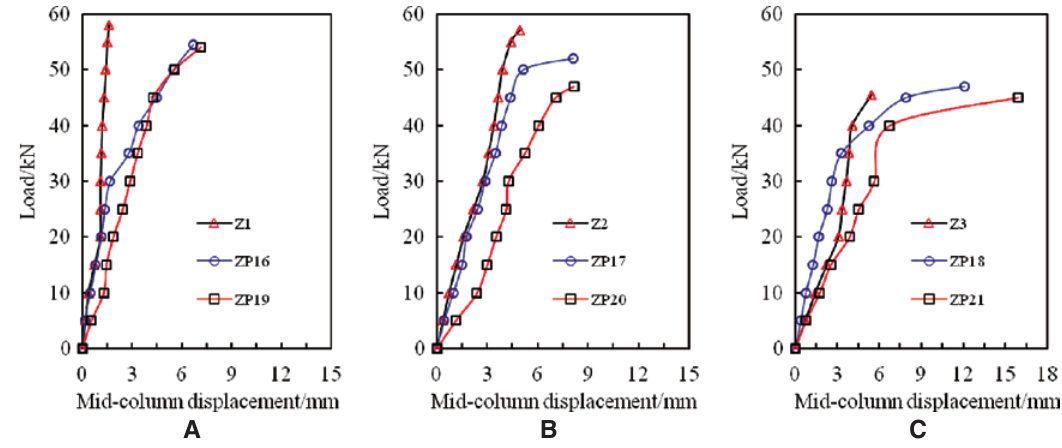
Figure 16: N-u curves for different